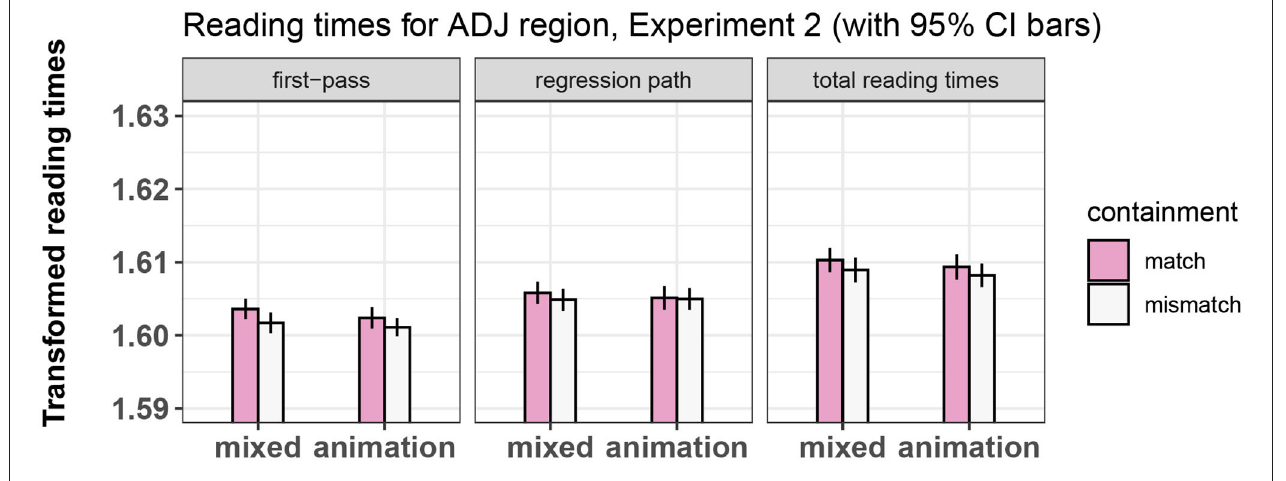
FIGURE 7 | Summary of results for the ADJ region, Experiment 2.